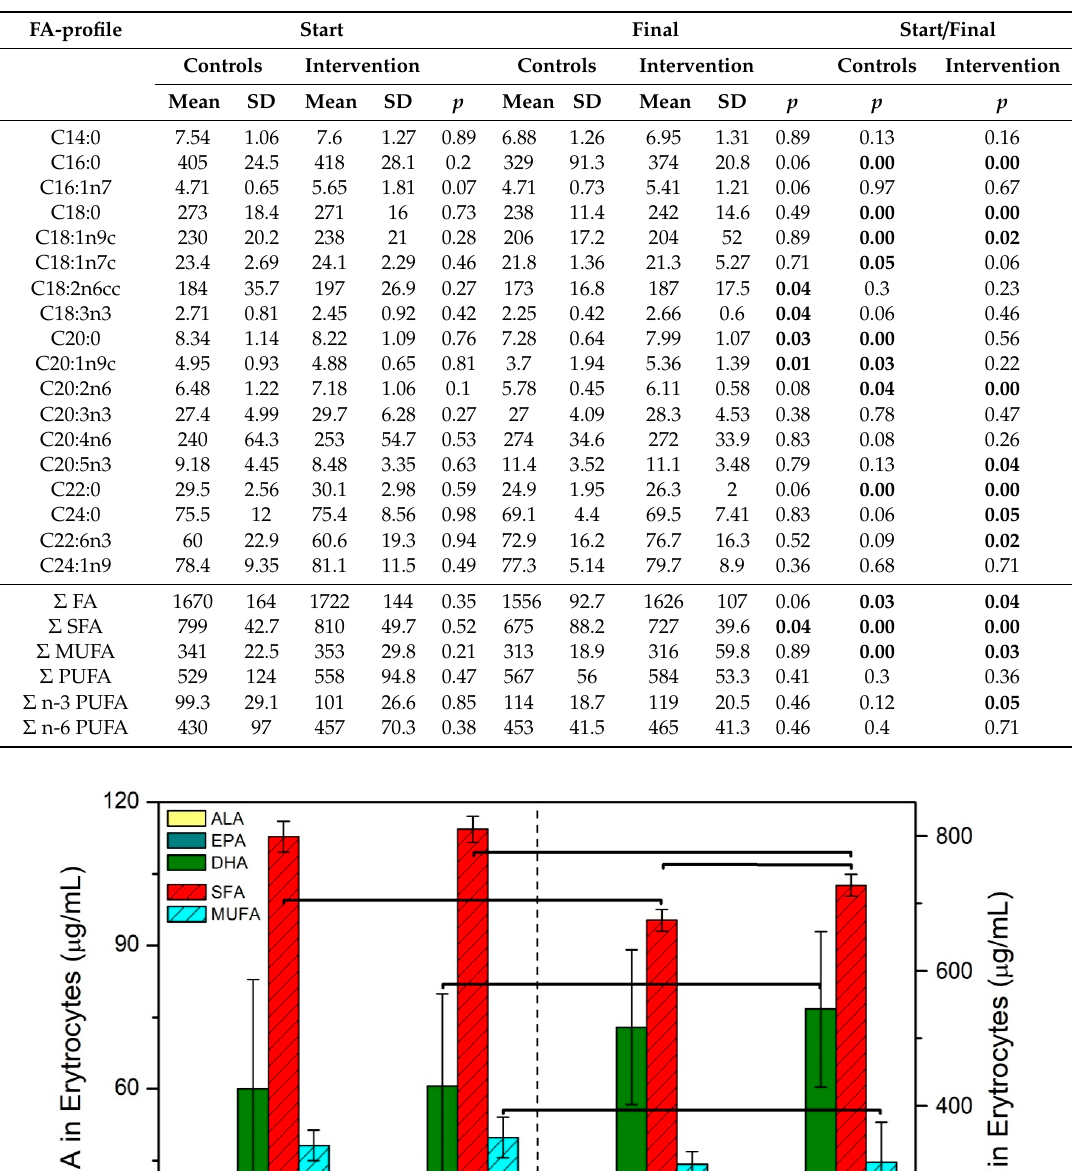
Table 6. FA profile in the erythrocytes during the intervention in µ g / mL.